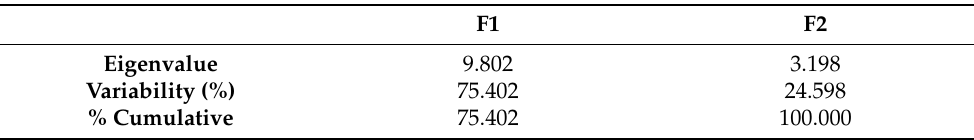
Table 5. Discrimination table for PCA models constructed with physicochemical properties and the chemical composition of walnut ( Juglans regia L.)